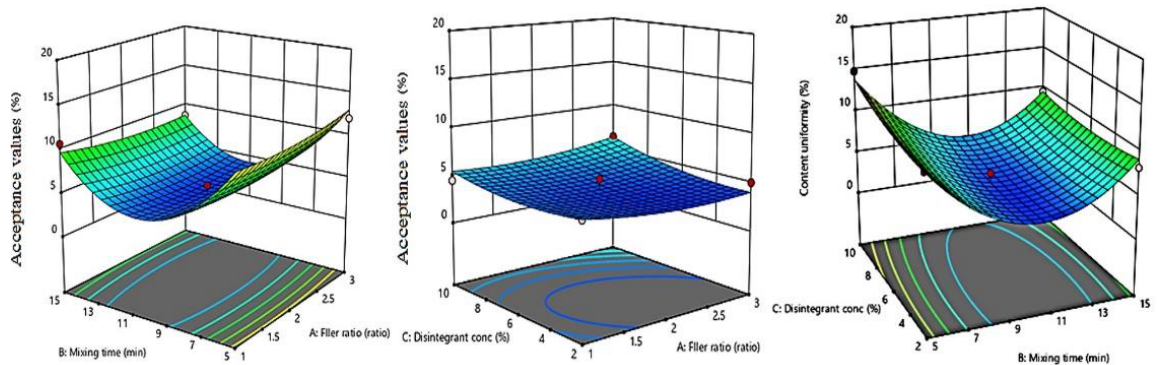
Figure 9. Influence of independent variables on the Acceptance value (Y4) with significance ( A ) p value = 0.9937, ( B ) p value = 0.1586, and ( C ) p value < 0.0134.